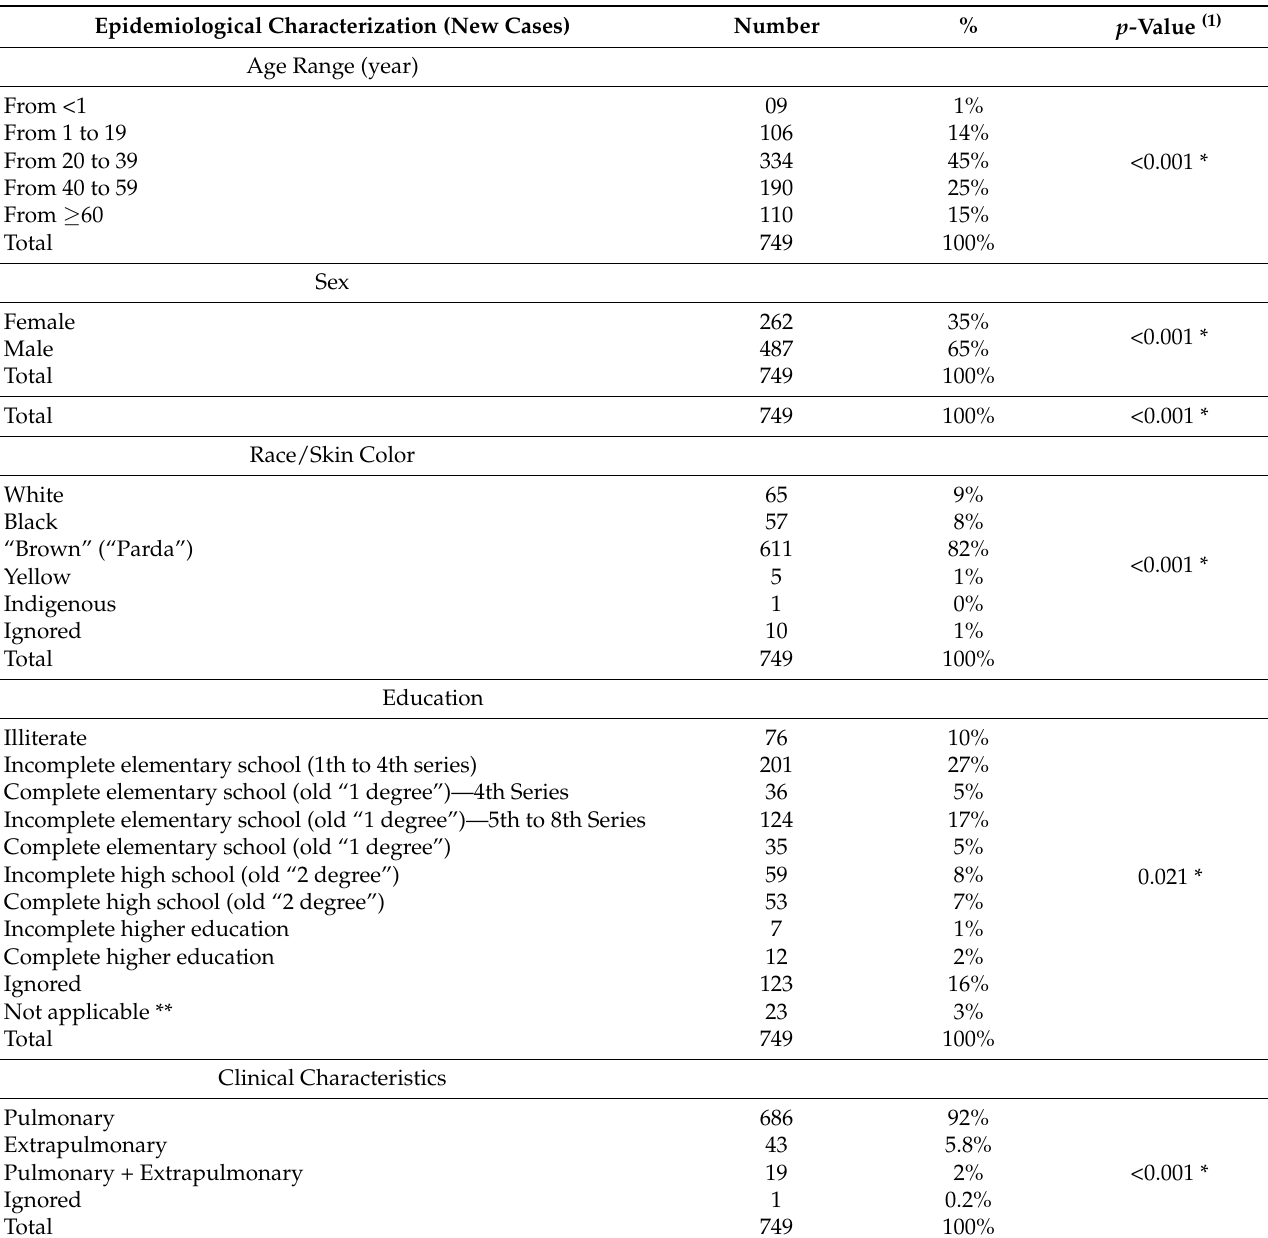
Table 1. Distribution of new human tuberculosis cases in Maraj ó Island, Par á -Brazil, according to epidemiological data. Epidemiological Characterization (New